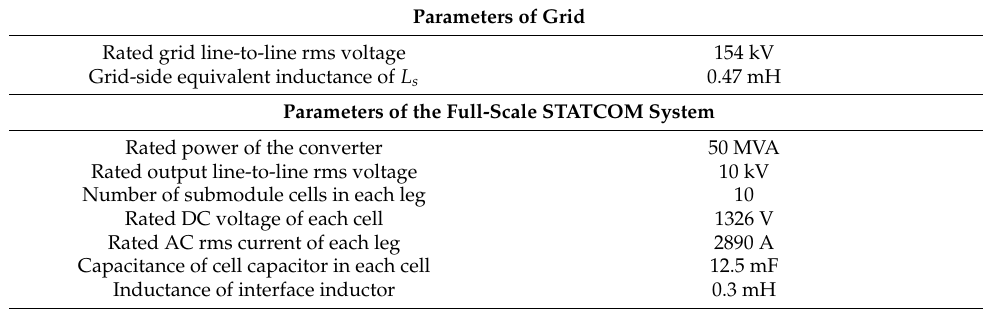
Table 1. Parameters of 50MVA STATCOM